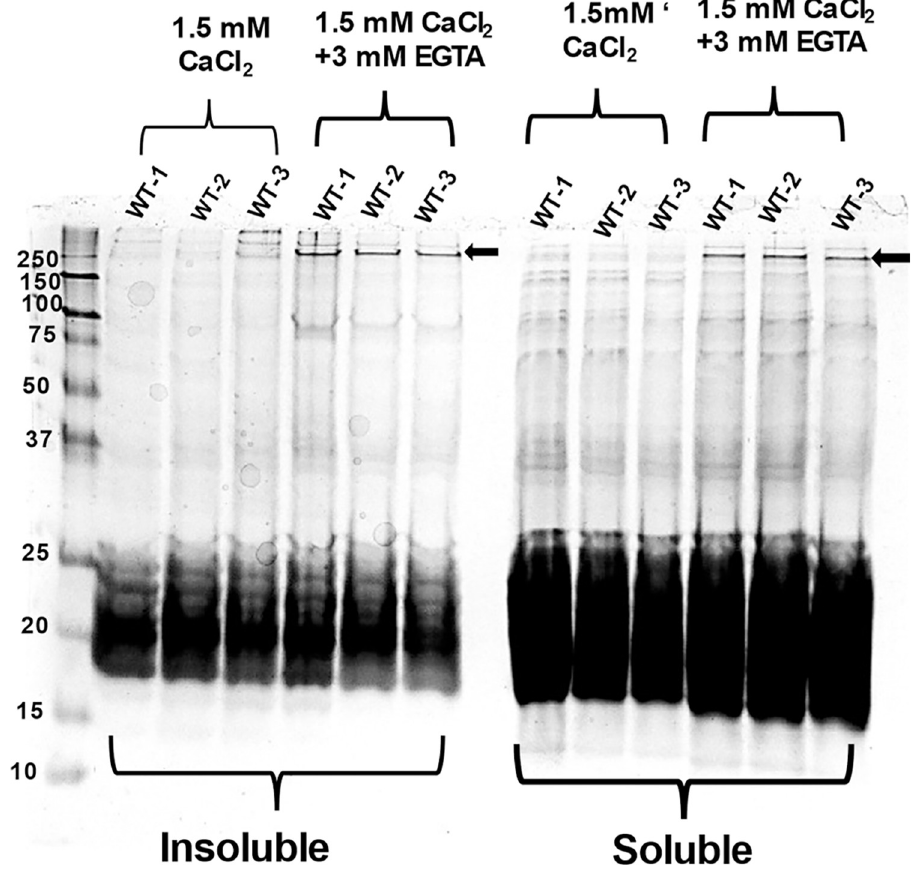
Fig 8. SDS-PAGE analysis of spectrin- degradation in water soluble (WS) and water insoluble protein fractions with addition of 1.5 mM CaCl 2 and without 3 mM EGTA in wild-type lenses. SDS-PAGE analysis to determine spectrin-degradation in water soluble (WS)- and water insoluble (WI) protein fractions from three wild-type lenses following incubation for 3 h with 1.5 mM CaCl 2 and with and without 3 mM EGTA. Note a 250 kDa protein band of α -spectrin was intact in the presence of EGTA but was absent in the absence of EGTA, suggesting that calpain proteolyzed the protein in the absence of EGTA. This suggested that calpain was active in proteolyzing α -spectrin in the presence of exogenous CaCl 2